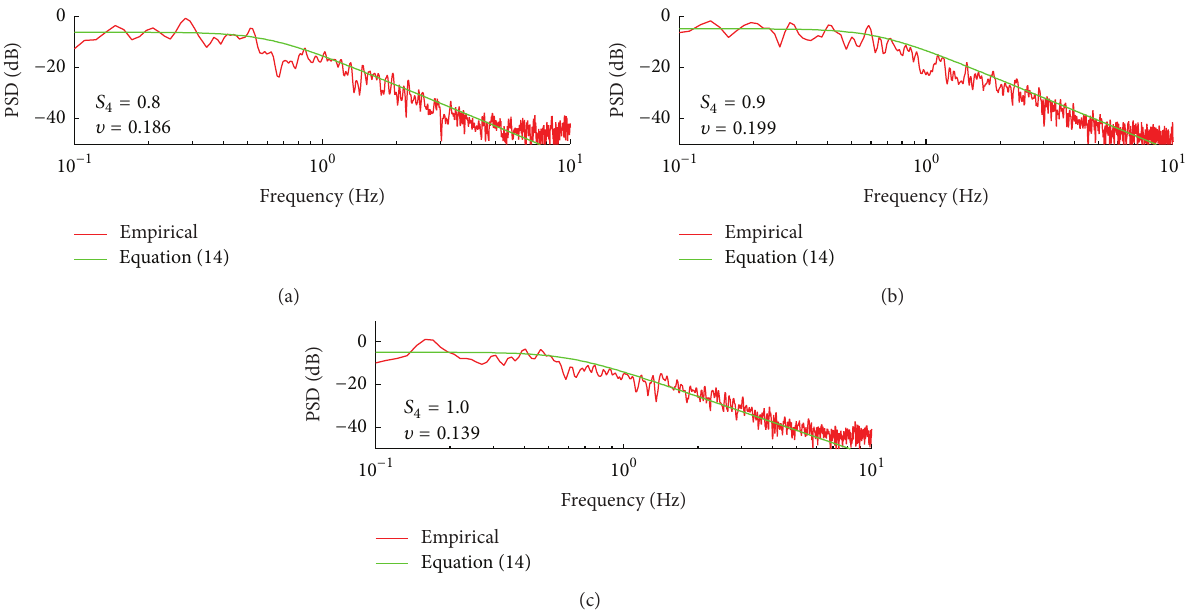
Figure 5: Estimated scintillation power spectral densities (red) and corresponding results (green) from the theoretical 𝛼 - 𝜇 formulation represented by (14) for different values of the scintillation index 𝑆 4 .